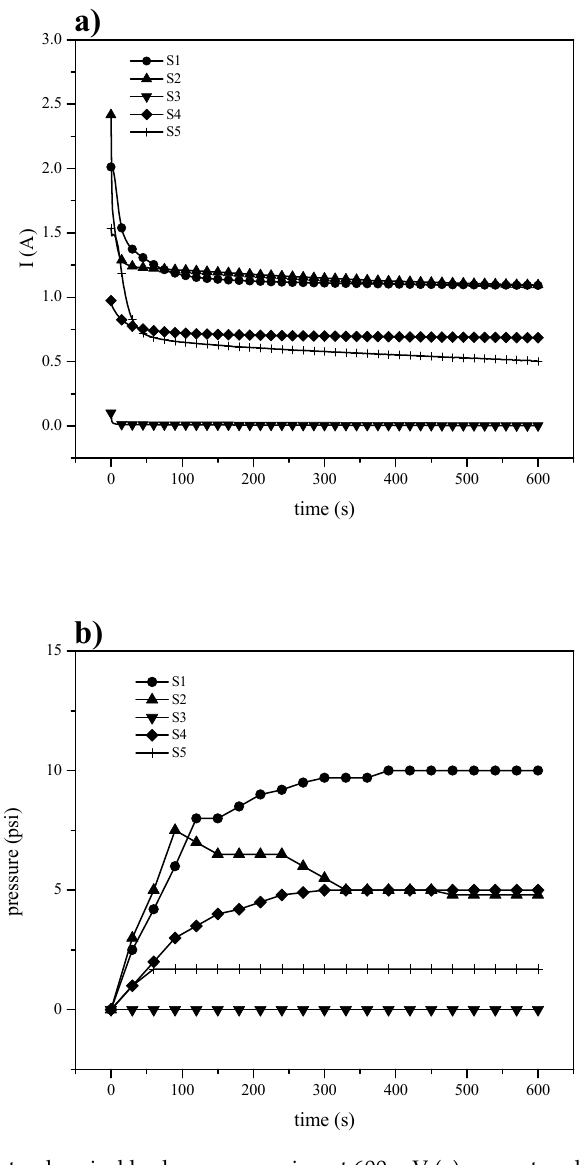
Figure 9. Electrochemical hydrogen pumping at 600 mV ( a ) current and ( b ) pressure.